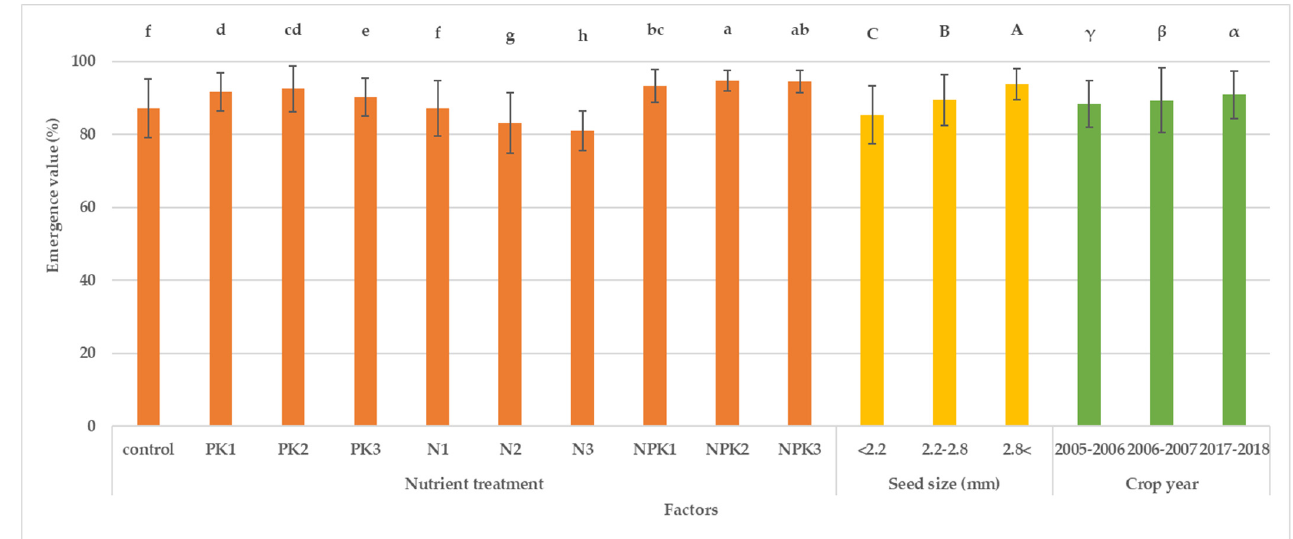
Figure 5. Effect of nutrient treatments, seed size and crop year on emergence percentage of winter wheat. (Values marked with different letters are significantly different at the p < 0.05 significance level. Small letters (a–h) represent nutrient treatments, capital letters (A–C) represent seed sizes and Greek letters ( α – γ ) represent years, where the order of the letters starts from the largest value. The standard deviation (SD) has been marked in the columns.)